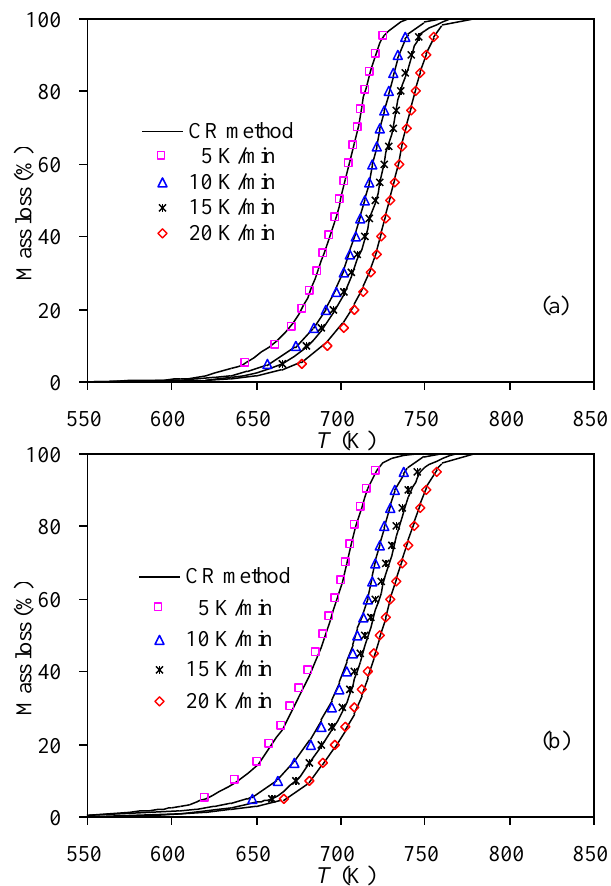
Figure 9. Recast α ~ T curves of for thermal degradation of nylon-6 wastes in ( a ) N 2 and ( b ) air.